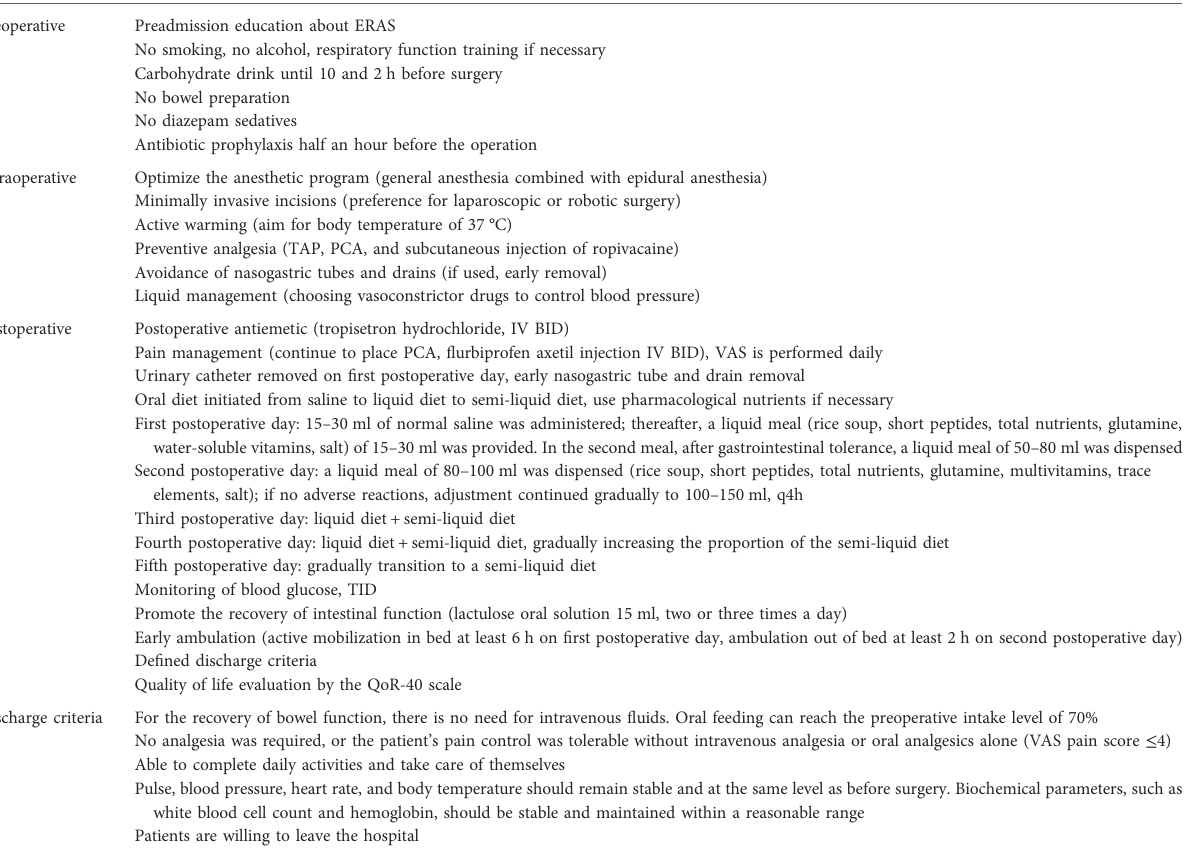
TABLE 1 Components of an ERAS